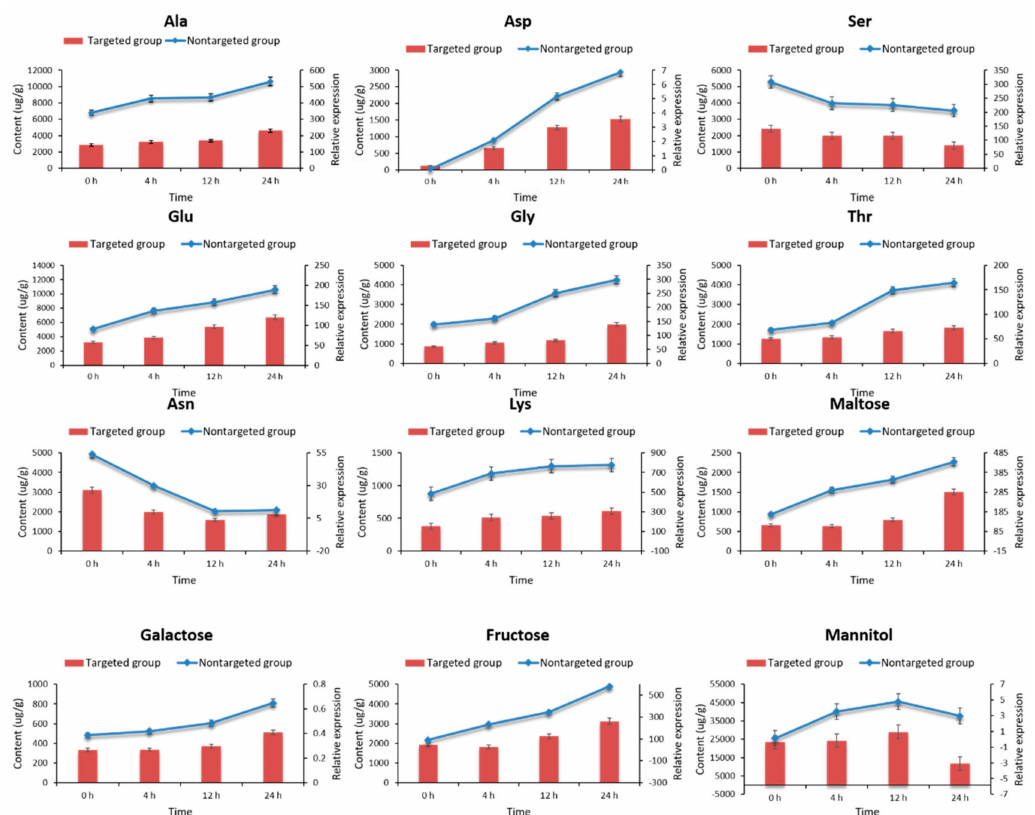
Figure 8. Verification of targeted metabolomics for the content changes of 12 metabolites. The targeted content determination result of 12 metabolites. The values are the means ± SD of three independent experiments. Note: Red bars with standard errors represent the content level determined by targeted GC–MS-based metabolomics (left Y-axis). Broken lines indicate the relative expression level determined by nontargeted GC–MS-based metabolomics (right Y-axis). All 12 metabolites were derived from strain